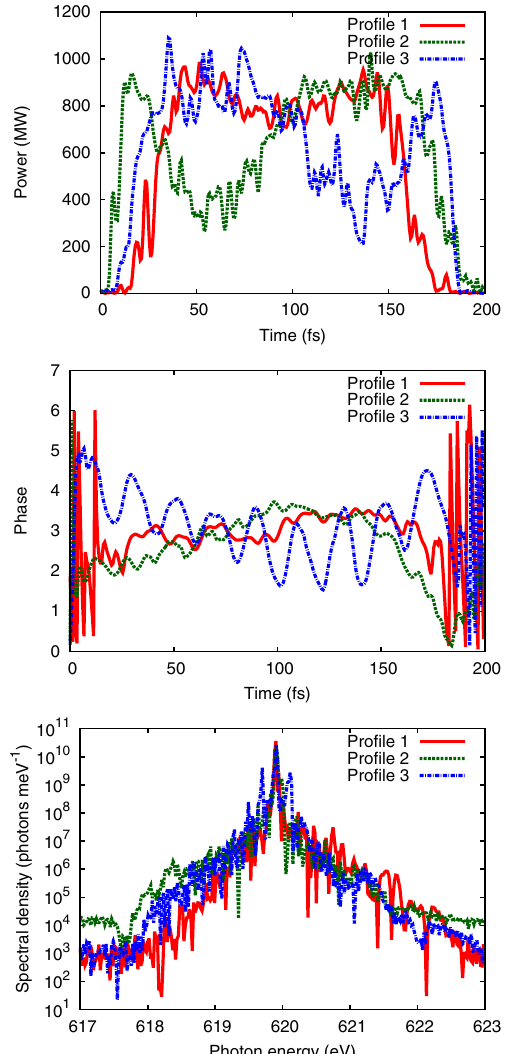
FIG. 8. Phase profiles at 8 nm immediately before upshifting to 2 nm in the combined EEHG and HGHG beam